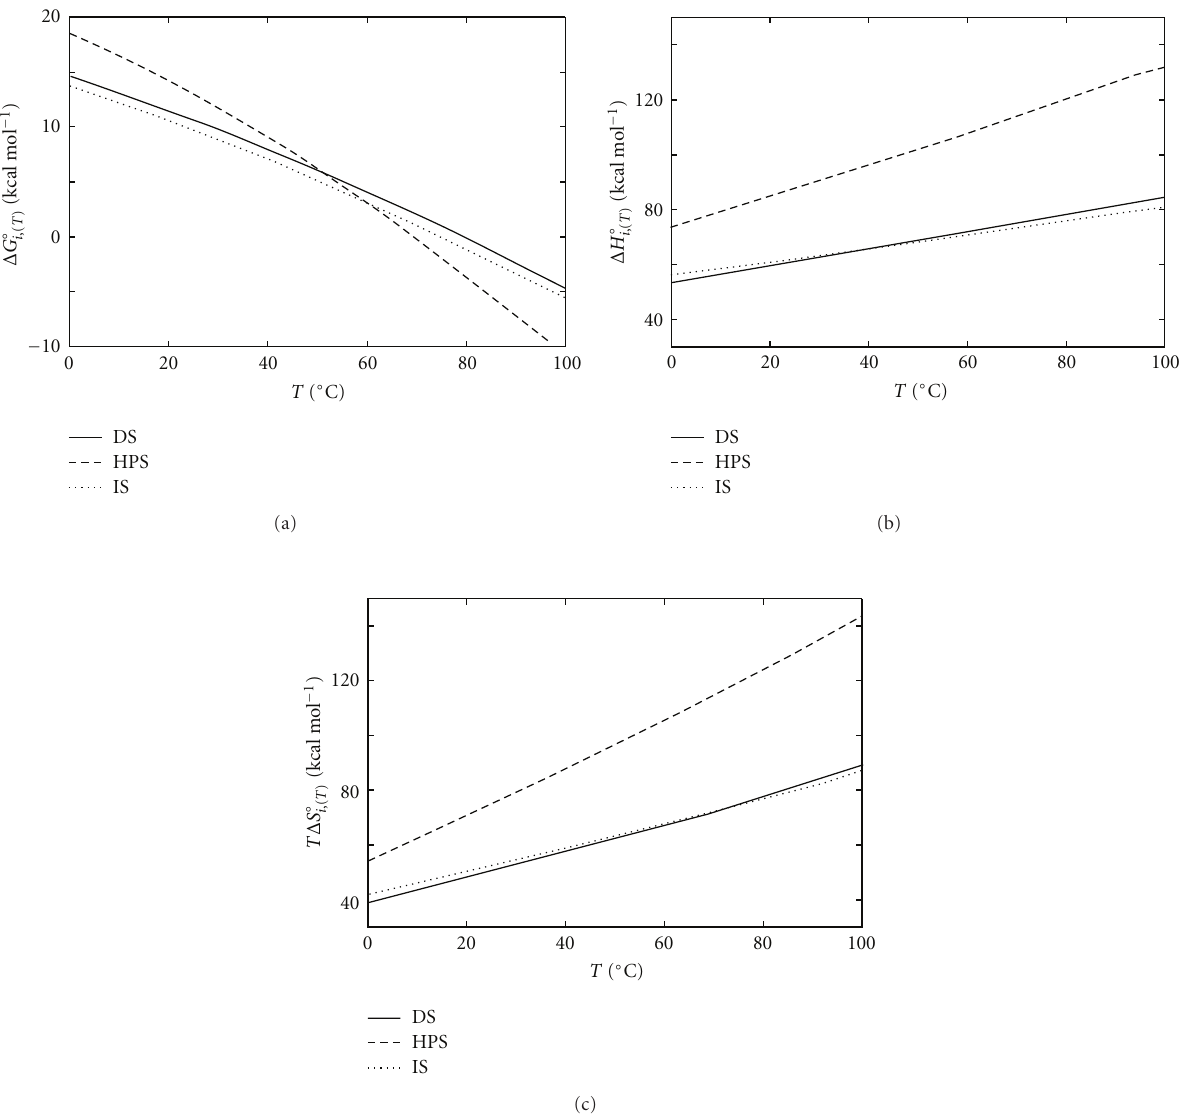
Figure 4: Thermodynamics of hairpin and duplex unfolding: standard Gibbs free energy (a), standard enthalpy (b), and the corresponding entropy contribution (c) presented for each model predicted hairpin (I → S, HP → S) and duplex (D → 2S) transitions as functions of temperature at [Na + ] =